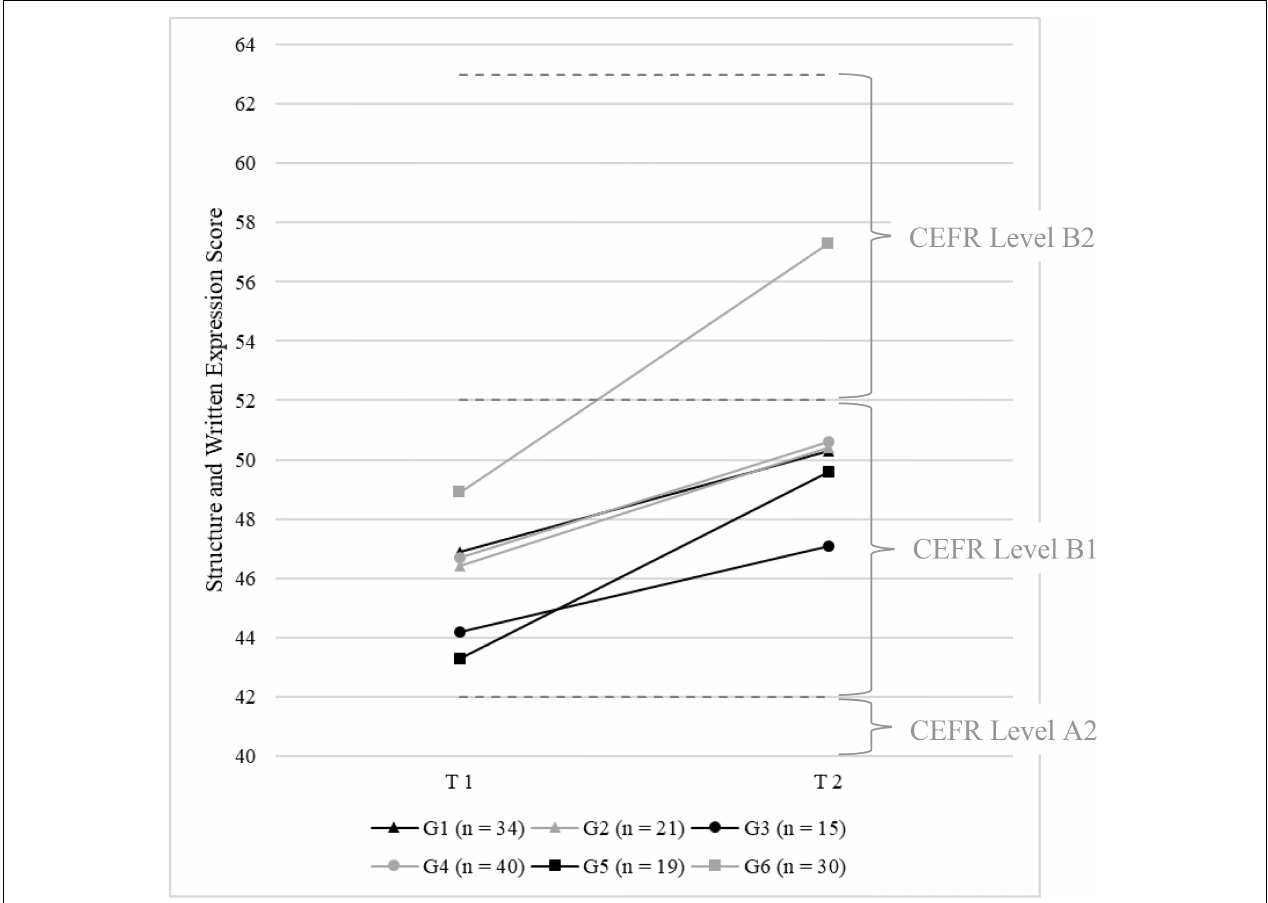
FIGURE 4 | Development of the English skills in the competence area “Structure and Written Expression” (from 31 = worst result to 68 = best result). T, Time of Measurement; G1, student-athletes with Additives Abitur at Elite Sport School 1; G2, student-athletes without Additives Abitur at Elite Sport School 1; G3, student-athletes without Additives Abitur at Elite Sport School 2/3; G4, dropouts at Elite Sport School 1; G5, dropouts at Elite Sport School 2/3; G6, non-student-athletes at comprehensive schools; CEFR, Common European Framework of References for